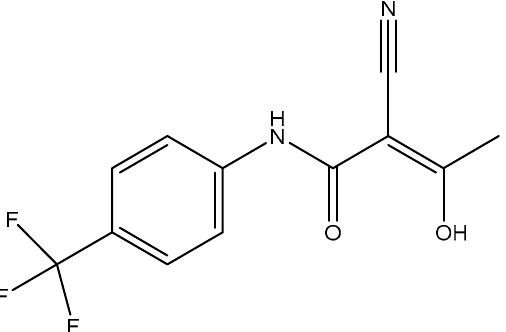
Figure 1. Chemical structure of teriflunomide (TFL). Table 1. Different molar ratios of initiator and co-initiator used for the synthesis of PCL polyesters with different molecular